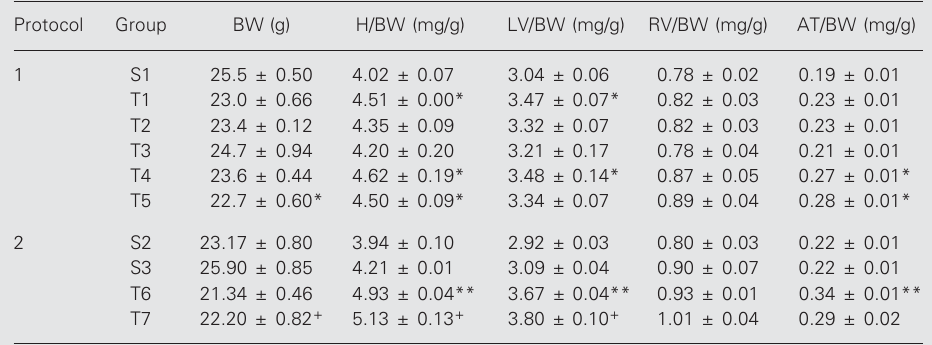
Table 2. Cardiac morphometric analysis following physical training in Protocols 1 and 2.